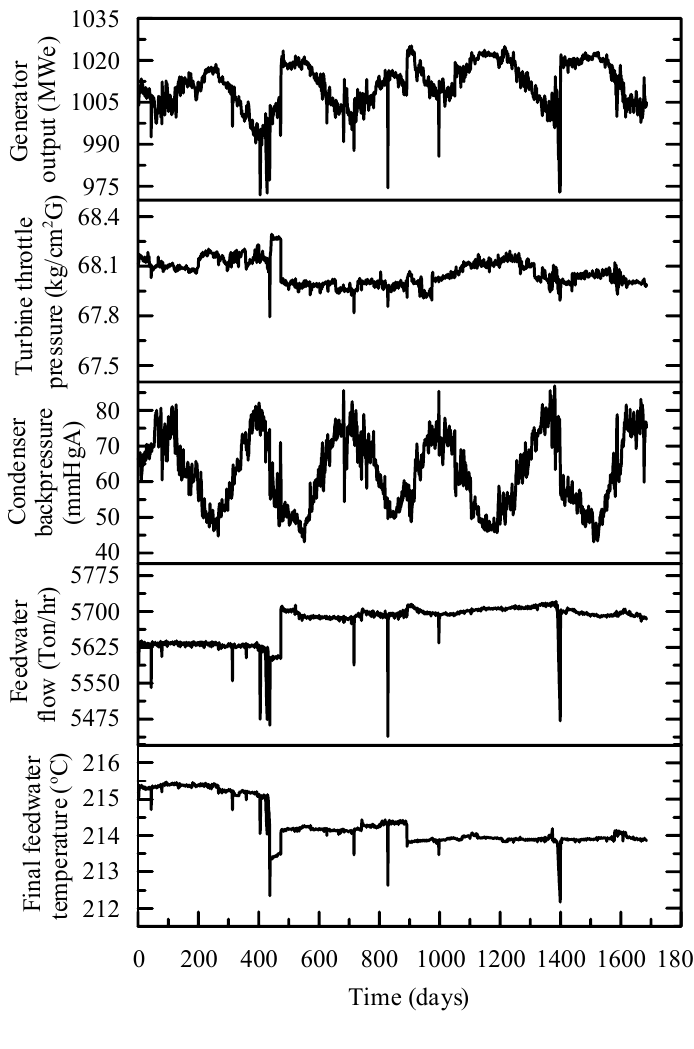
Figure 7. Trend data for generator output, turbine throttle pressure, condenser backpressure, feedwater flow rate, and final feedwater